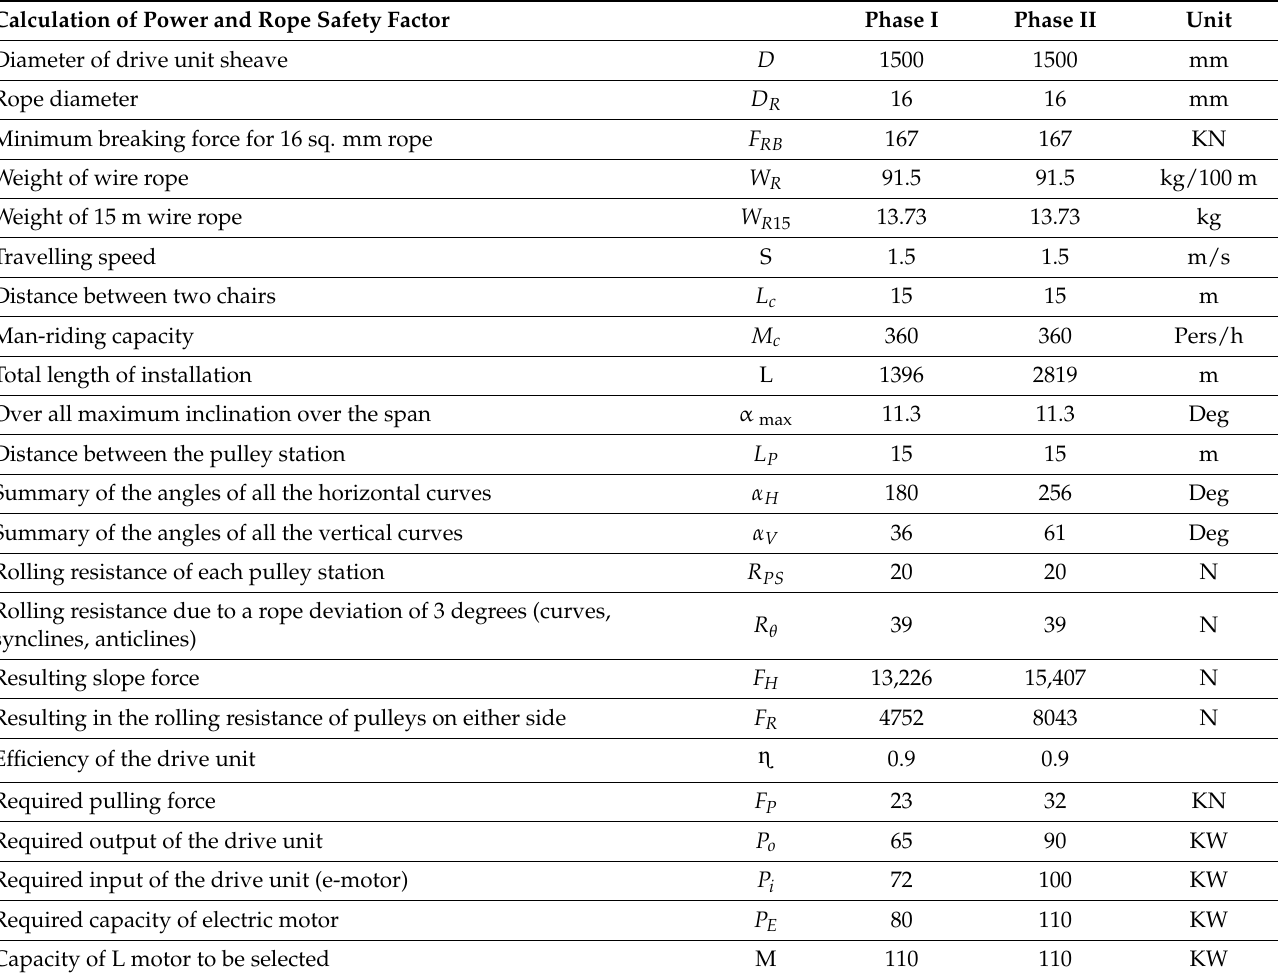
Table 5. Power and Factor of Safety Calculation.